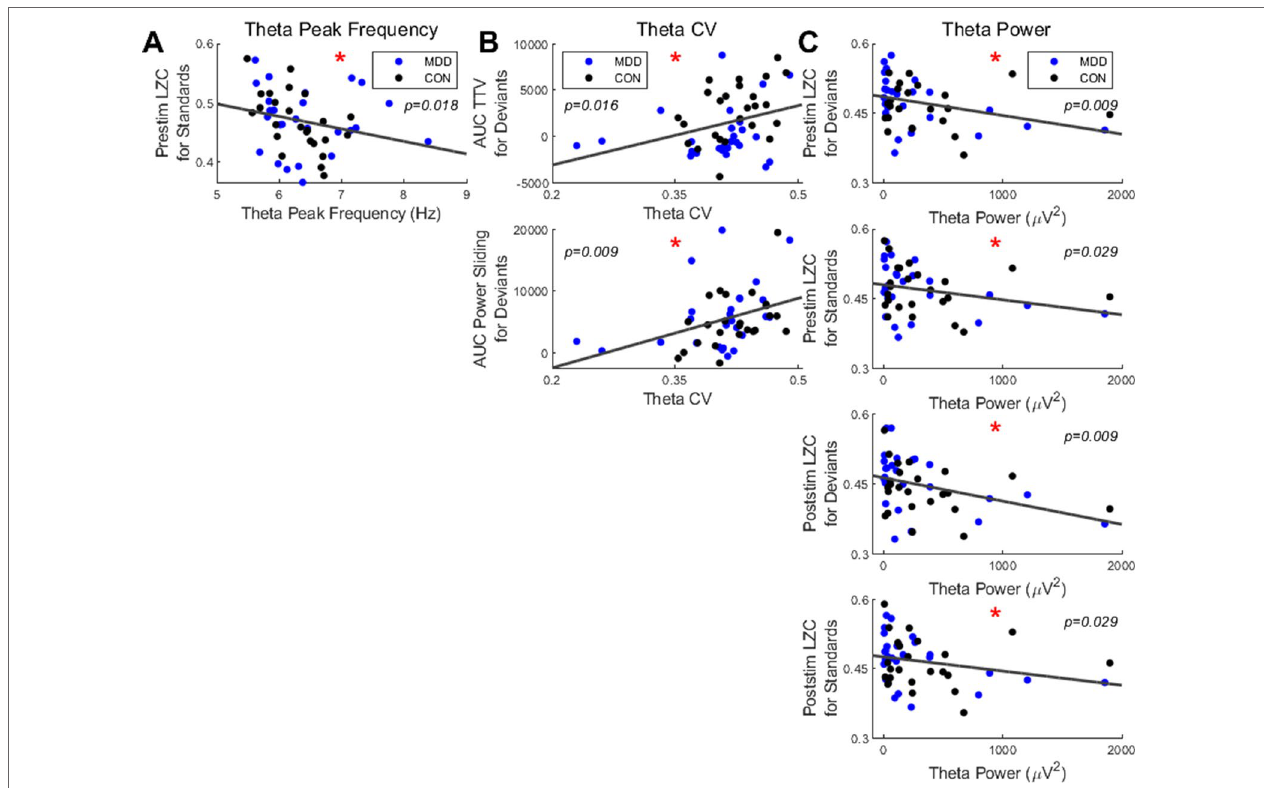
FIGURE 6 | Spearman correlations found significant relationships between resting state measures in the theta band and LZC in both stimuli and PS and TTV AUC in deviant stimuli. (A) Resting state theta PF had a negative correlation with prestim LZC in standard stimuli. (B) The CV in the theta band had significant correlations with PS and TTV AUC for deviant stimuli. (C) Resting state theta power had significant negative correlations with both pre- and poststim LZC in both bands. All p -values are FDR corrected for multiple comparisons. *: <